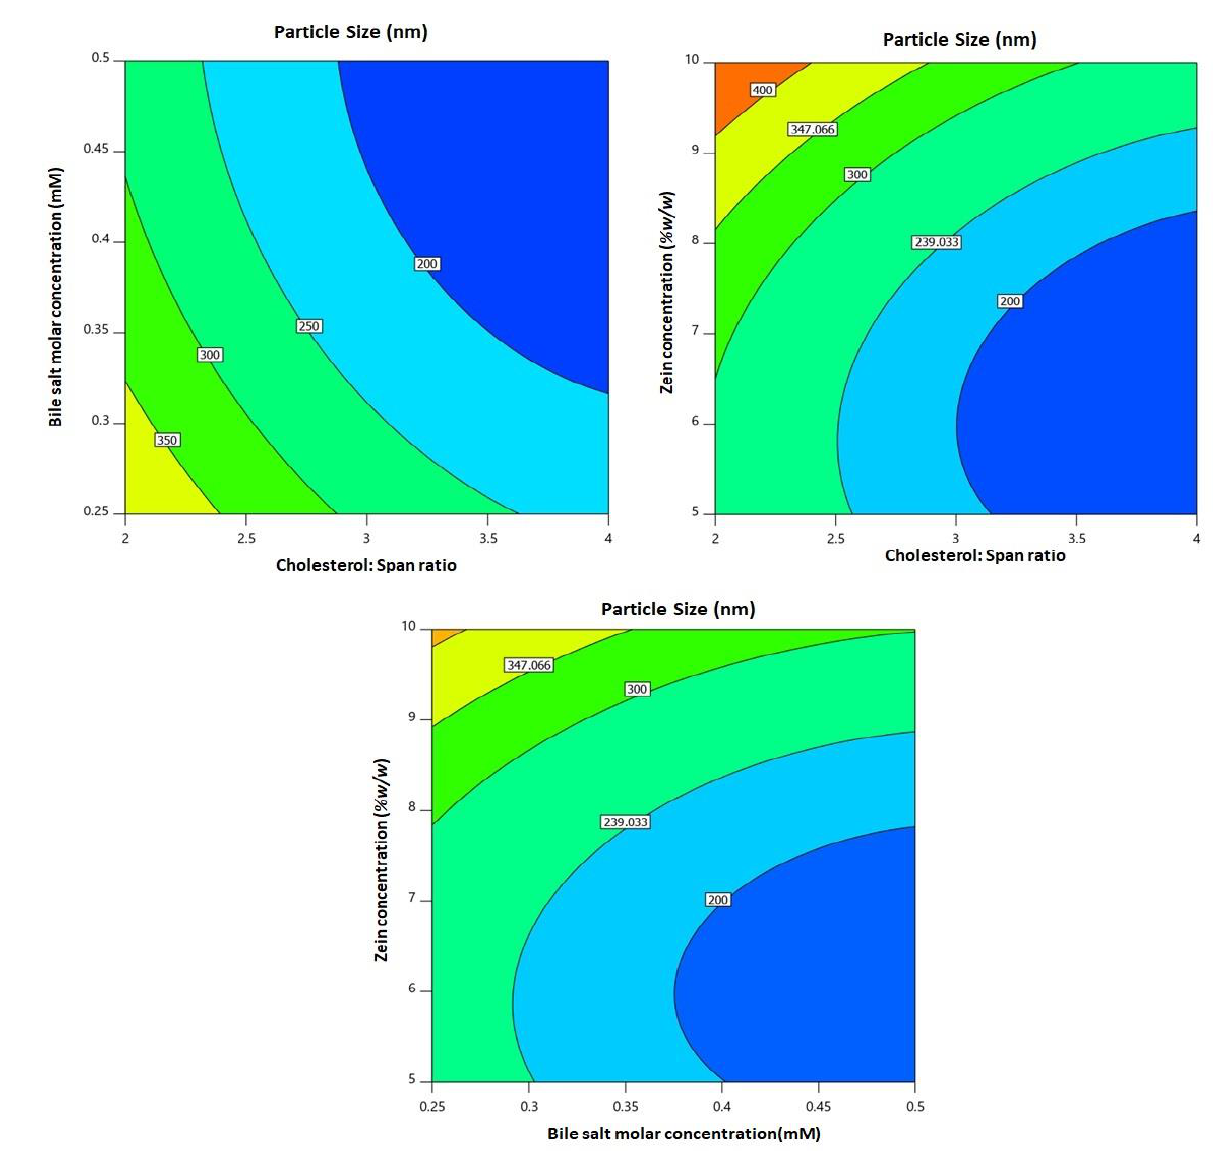
Figure 2. 2D contour plot for the influence of formulation variables on the particle size of PIC-BZ.